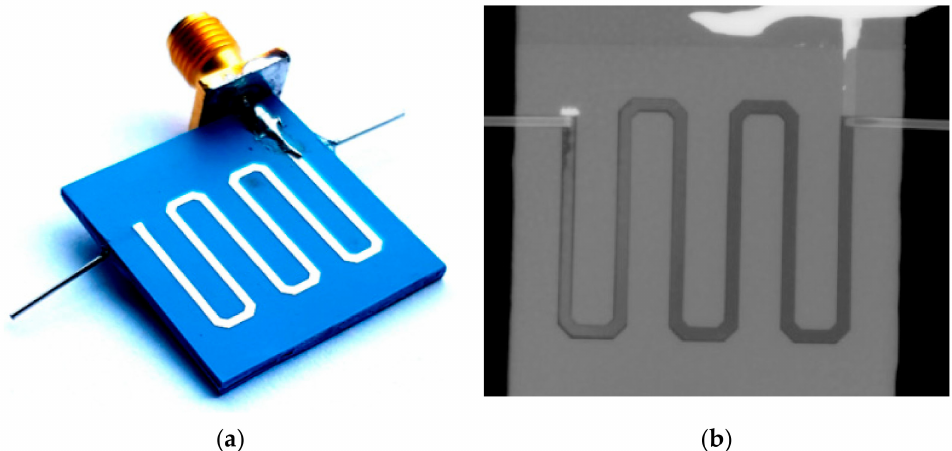
Figure 6. The photo of the Low-Temperature Cofired Ceramic (LTCC) device of heating ( a ) and the X-ray image with the microchannel placed below the microstrip line ( b ).